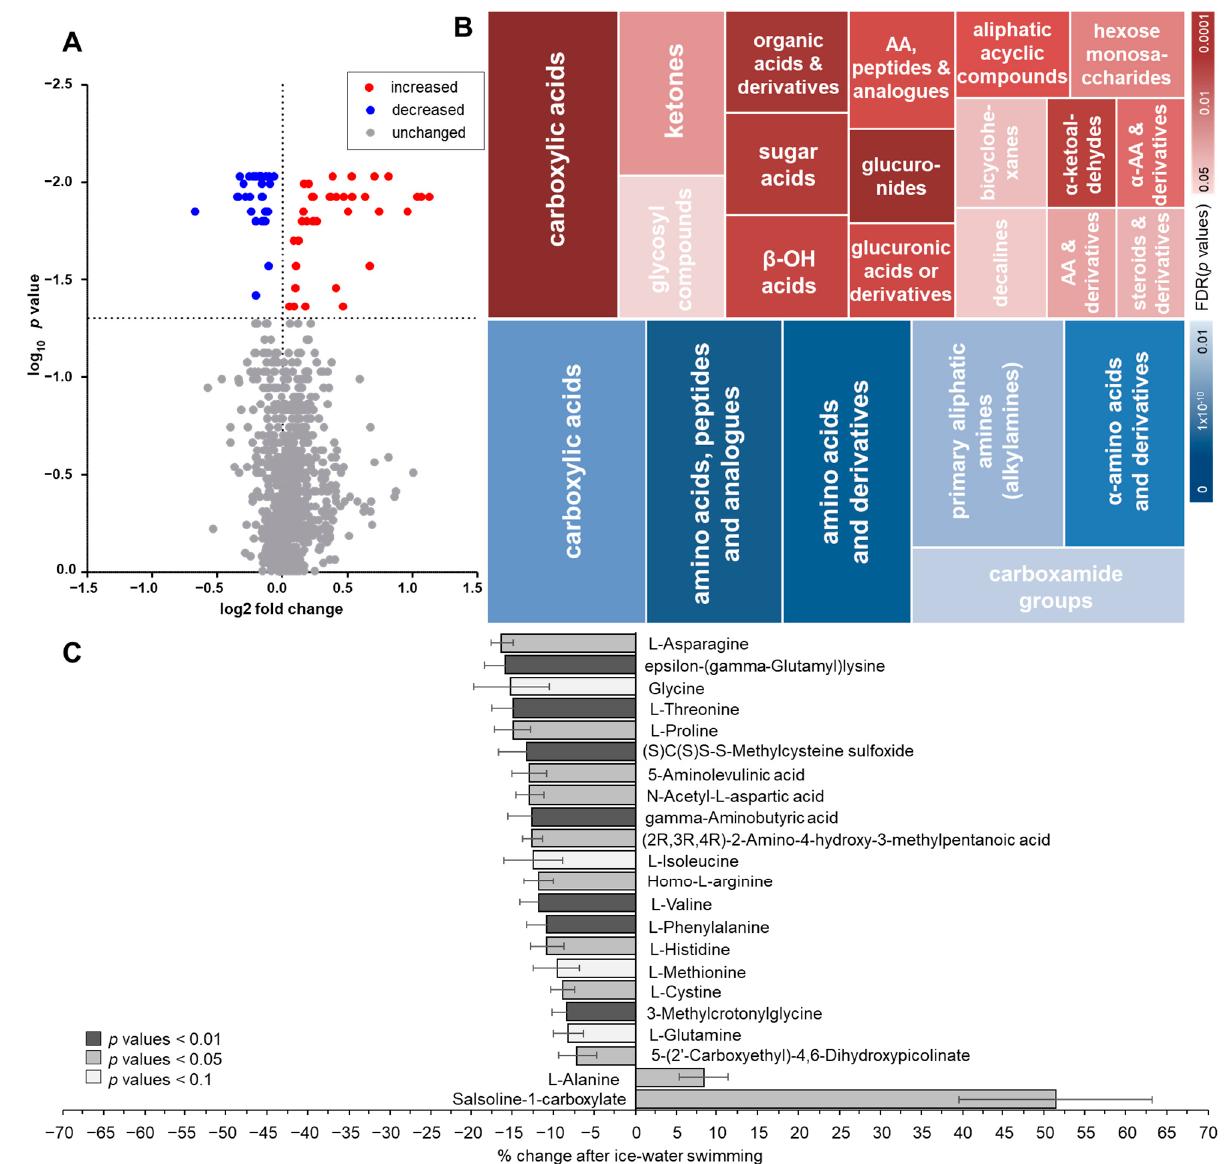
Figure 2. Changes in plasma metabolome in response to an acute bout of ice-water swimming characterized by ( A ) a volcano plot of the changed metabolites analyzed by Wilcoxon matched pairs signed-rank test with Benjamini–Hochberg correction and ( B ) analysis of the metabolic groups’ taxonomy enrichment of the increased (upper panel) and decreased metabolites (lower panel) based on HMDB taxonomy, performed by enrichment analysis (MBROLE 2.0) with minimum of 3 metabolites per group. Size of the tiles represents the relative percentage of matched metabolites in group, the shade of the tiles represents the significance of the enrichment (FDR-adjusted p values) and ( C ) analysis of ice-water swimming-induced changes in amino acids (AA) and their derivates.